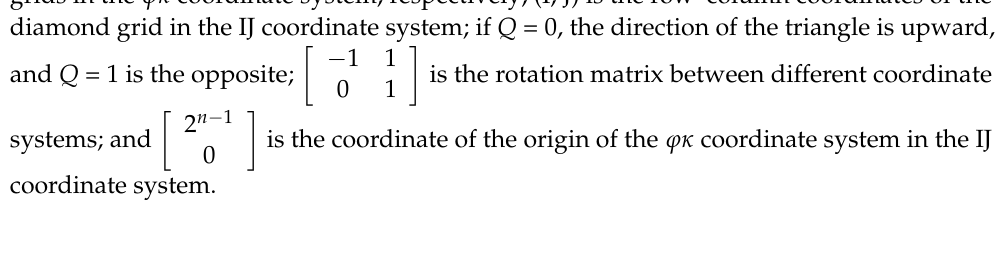
Figure 20. The ϕκ coordinate system of the rhombic grid.